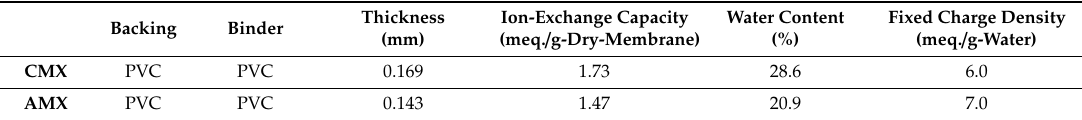
Thickness Ion-Exchange Capacity (mm) (meq. / g-Dry-Membrane)